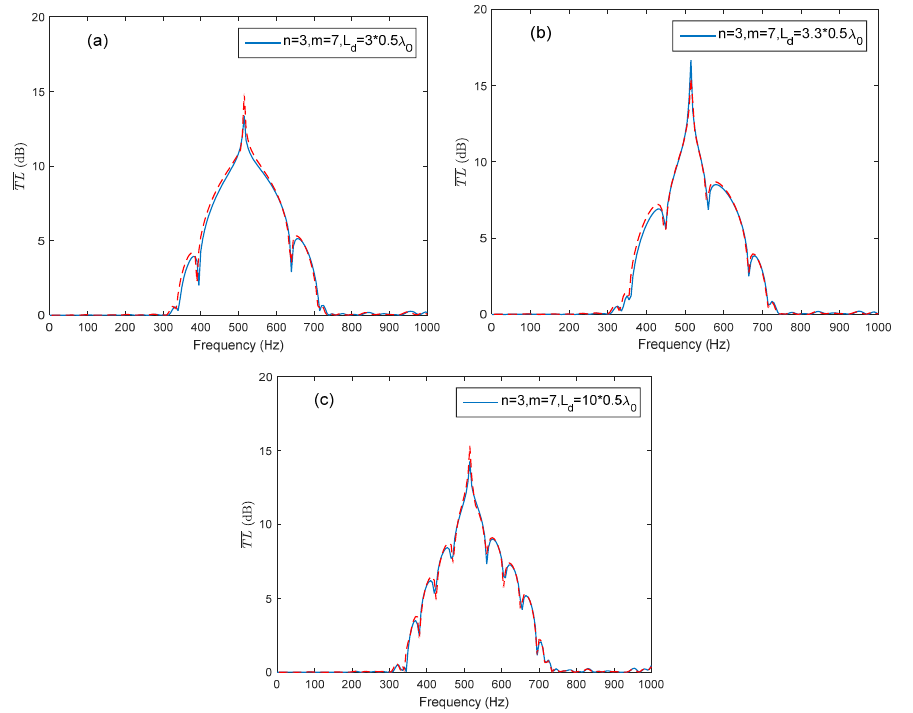
Figure 10. The average transmission loss of the HR array consist of two periodic parts ( n = 3, m = 7) with different connection tube length L d (solid lines represent the theoretical predictions, and dashed lines represent the FEM simulation results): ( a ) L d = 3 × 0.5 λ 0 ; ( b ) L d = 3.3 × 0.5 λ 0 ; ( c ) L d = 10 × 0.5 λ 0